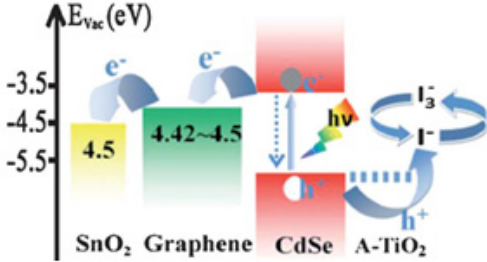
Figure 5. Schematic diagrams of the energy levels in the reduced graphene oxide-CdSe based quantum dot sensitized solar cell [60]. Reprinted with copyright permission from [108]. Copyright © 2011, American Institute of